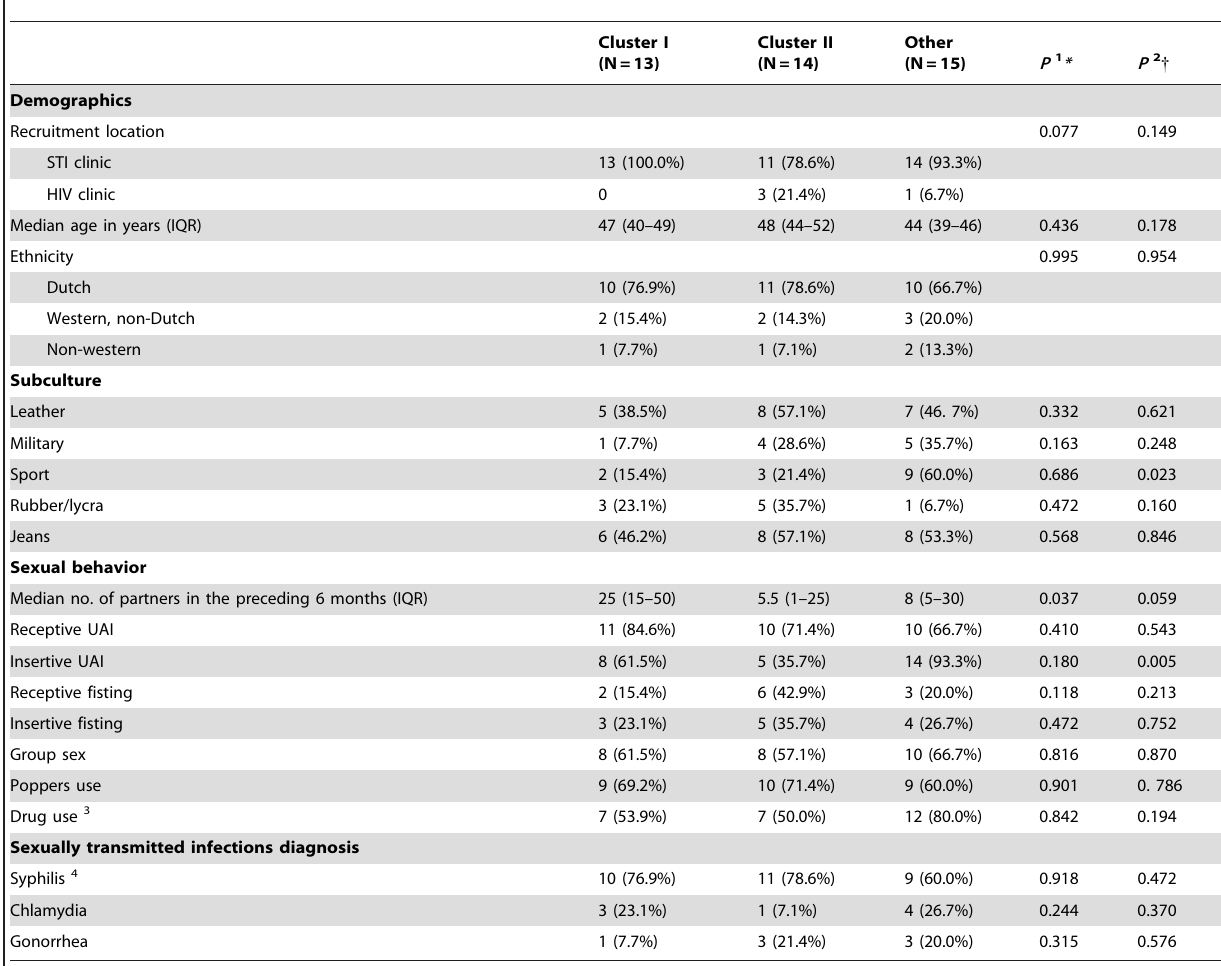
Table 5. Epidemiological characteristics of 42 men who have sex with men who tested hepatitis C RNA-positive, by phylogenetic cluster, Amsterdam, 2008–2009.